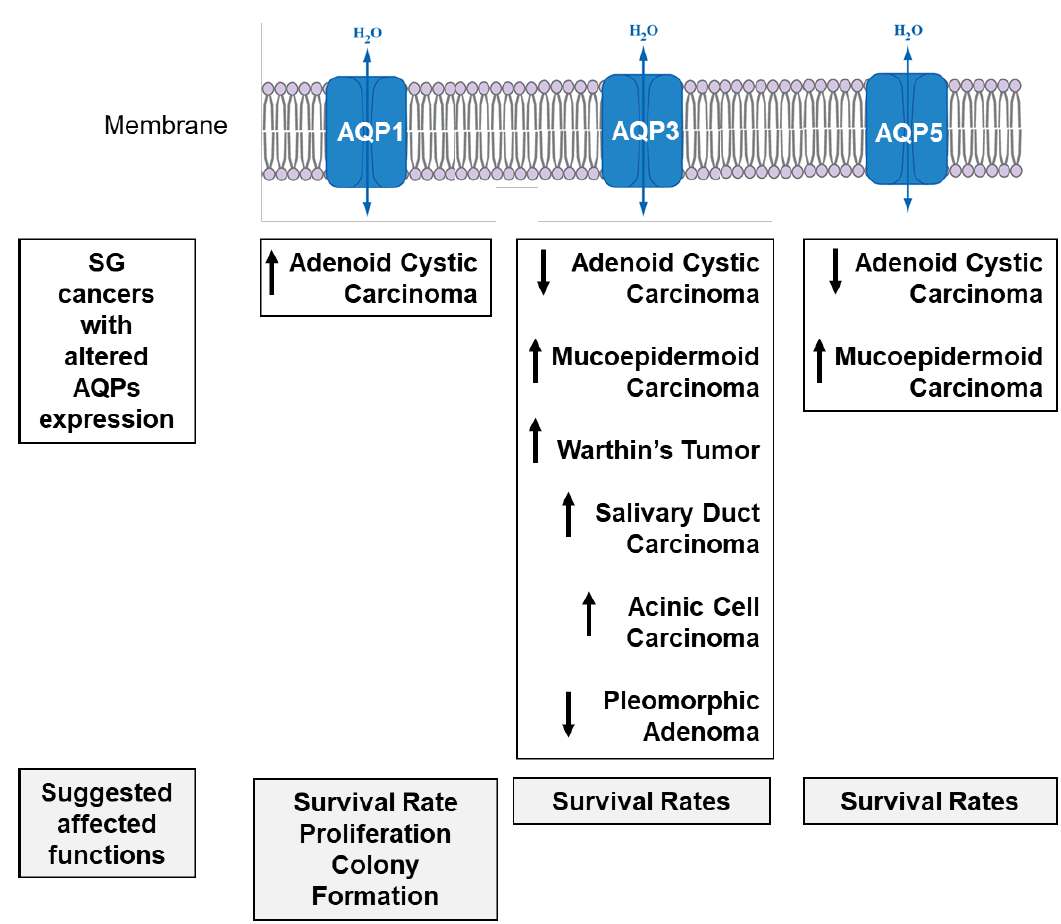
Figure 4. SG cancers with altered AQP1, AQP3 and AQP5 expression and their potential effects on functions. Top of diagram: List of different SG cancer types reported with an increase ( ↑ ) or decrease ( ↓ ) in the expression of AQPs when compared to their normal tissues. Bottom of diagram: A list of possible effects on cancer function due to altered AQPs expression.